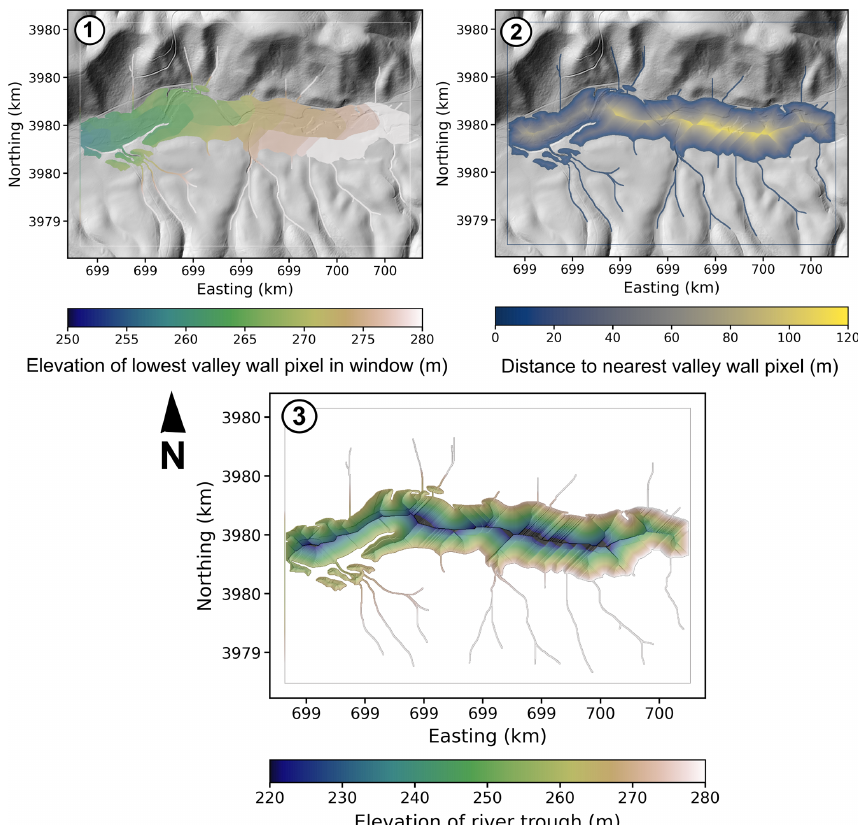
Figure 2. Step-by-step automated extraction of the channel centreline from topographic data: example from 1m lidar digital terrain model (DTM) from Gabilan Mesa, California. Coordinates are WGS84 UTM zone 10N. The floodplain mask is first extracted using the method of Clubb et al. (2017). (1) The minimum valley wall (non-floodplain) pixel elevation is then mapped onto every pixel in the floodplain; the minimum elevation is determined by the lowest valley wall elevation within a circular window around each floodplain pixel. (2) In addition, the distance of every pixel within the floodplain to the nearest valley wall pixel is calculated. (3) An elevation is then subtracted from the minimum elevation using Eq. (2) which incorporates the distance to the nearest valley wall. This results in a “trough” that is roughly V-shaped in cross section. Flow is routed down this trough to extract the valley